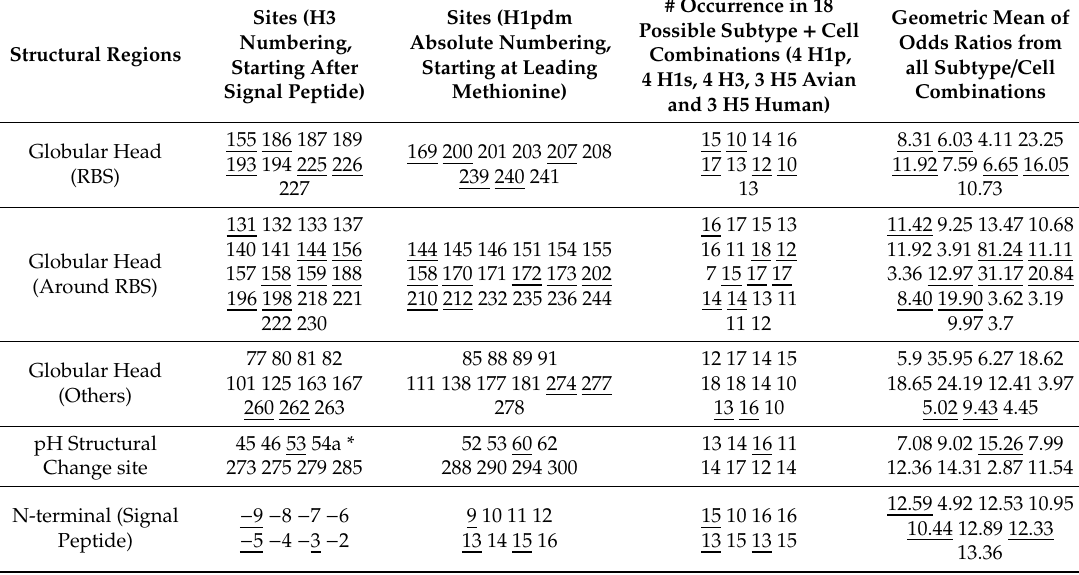
Table 2. Dominant common passage bias sites in HA. Passage bias sites were identified using (i) same strain di ff erent passage (SSDP) analysis, (ii) large-scale analysis of sequence and passage data until May 2013, and (iii) large-scale analysis for sequence and passage data from June 2013 to May 2019. The 54 passage bias sites listed in this table are found in at least 2 out of 3 of the above mentioned analyses. The 19 passage bias sites that are found in all 3 analyses are